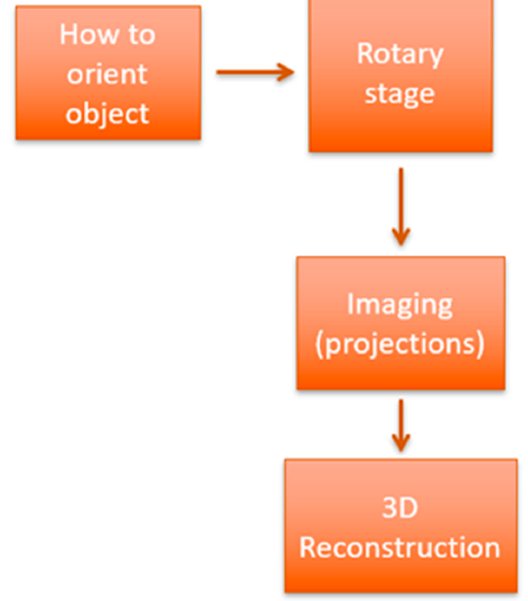
Figure 2. Generic computed tomography (CT) procedure that is completed manually.